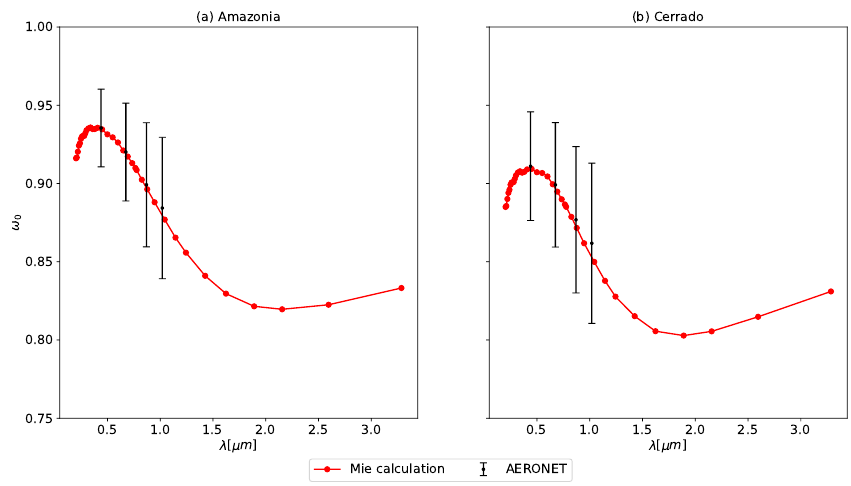
Figure A1. Single scattering albedo interpolated for the 37 spectral intervals of BRASIL-SR: ( a ) Amazonia. ( b ) Cerrado. AERONET mean values for the biomass burning period are indicated; vertical vars are the standard deviations.